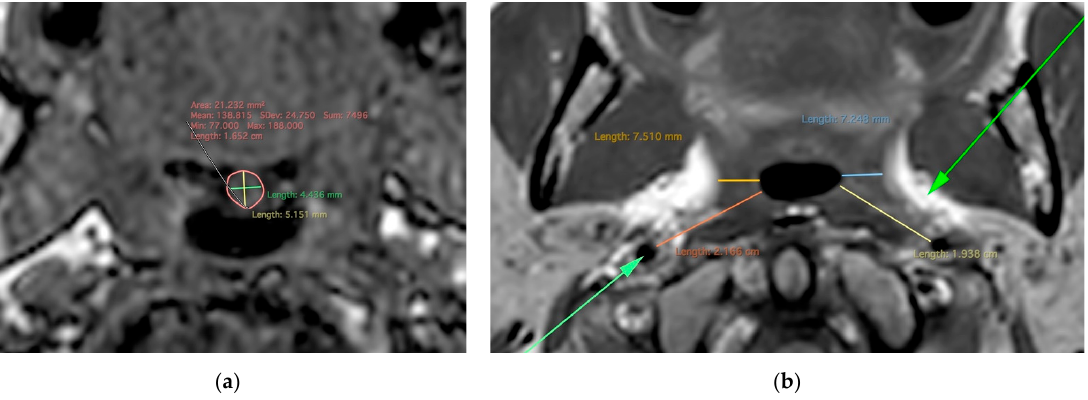
Figure 3. ( a ) Measurements of the tongue on T1 sagittal plane. Yellow: anteroposterior diameter, orange: thickness, purple: area; ( b ) Measurements of the soft palate on T1 sagittal plane. Orange: length, blue: thickness, purple: area.